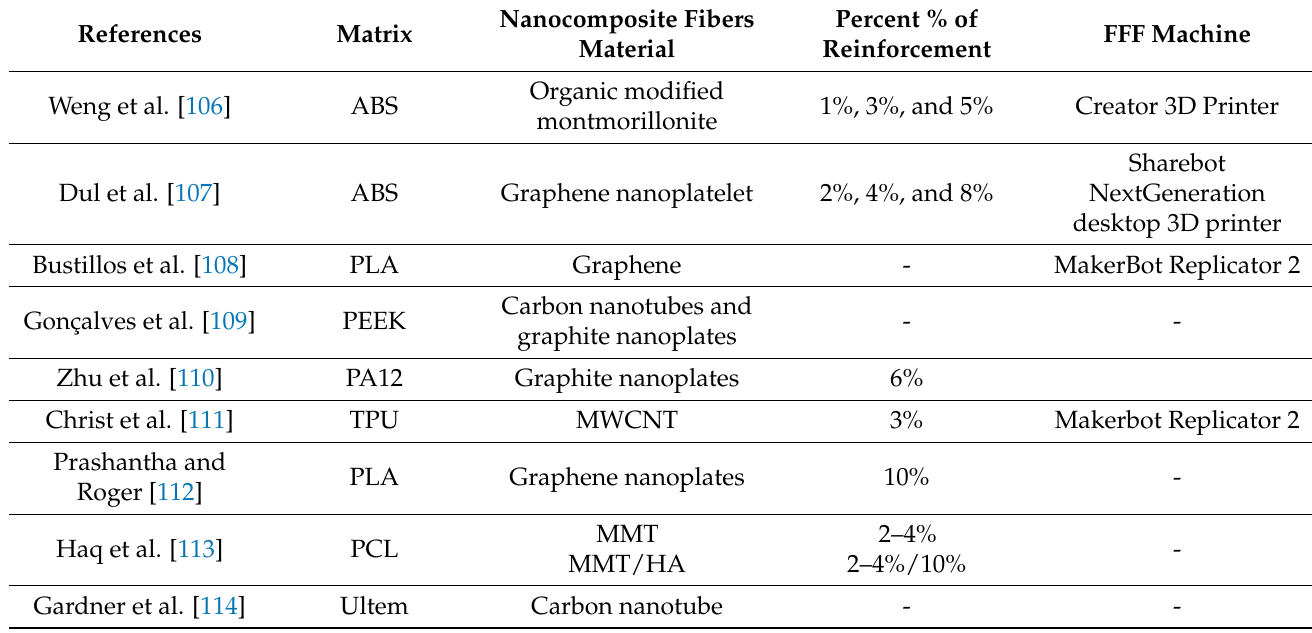
Table 7. Nanocomposites for filaments. ABS—acrylonitrile butadiene styrene, PLA—polylactic Acid, PA12—polyamide 12, PEEK—polyether ether ketone, PCL—polycaprolactone, TPU—thermoplastic polyurethane, HA—hydroxyapatite, MWCNT—multiwall carbon nanotubes, MMT—nano